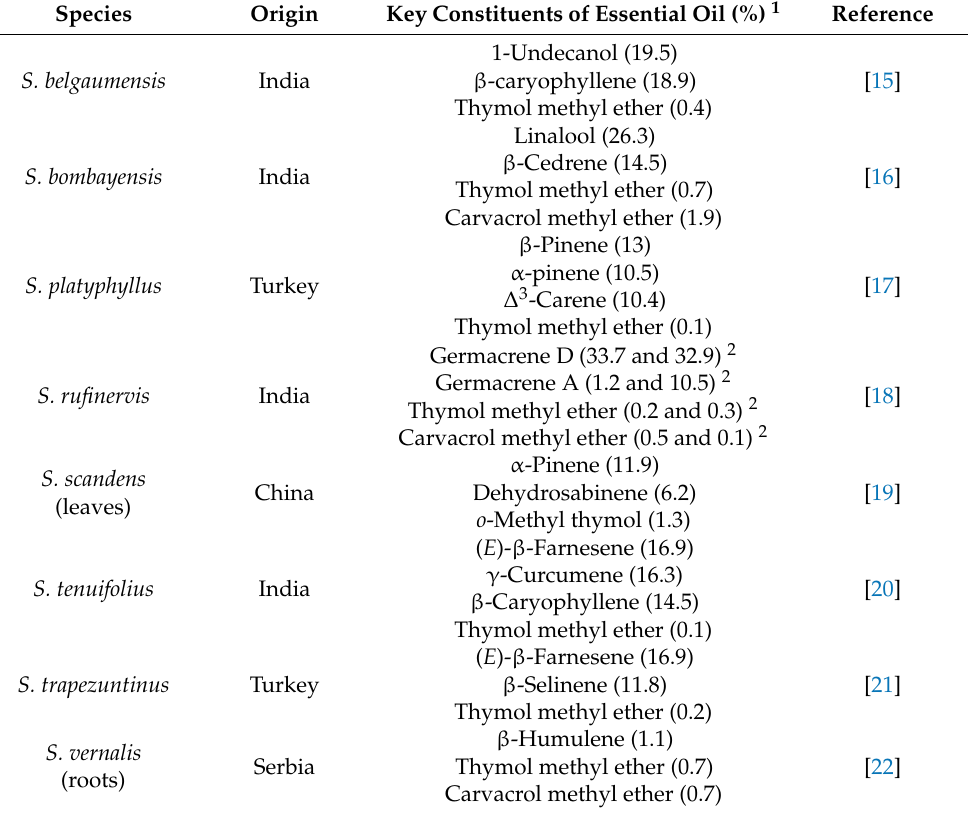
Table 2. Essential oils of Senecio species containing thymol methyl ether and